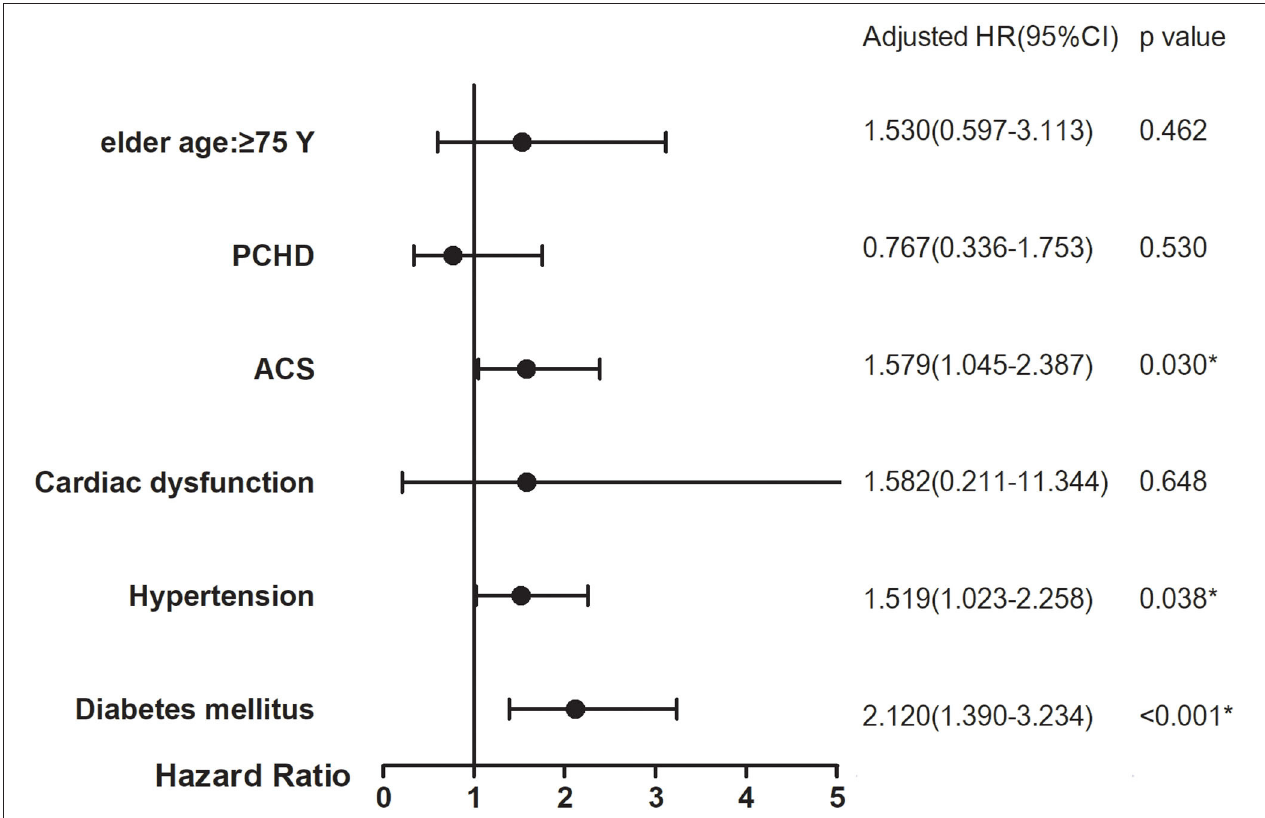
FIGURE 3 | Subgroup analyses on 5-year stroke between prior stroke and non-prior stroke. p -Value for interaction in each subgroup analysis for adjusted HRs. * p < 0.05.